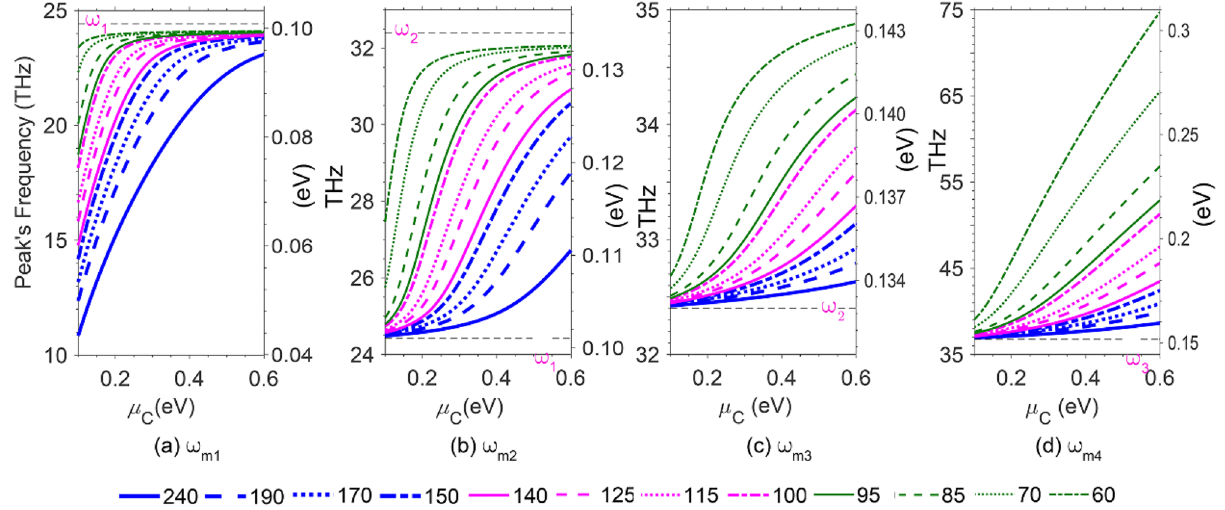
Figure 6. The peak frequency of the hybrid mode ( a ) ω m1 , ( b ) ω m2 , ( c ) ω m3 , and ( d ) ω m4 versus chemical potential ( μ